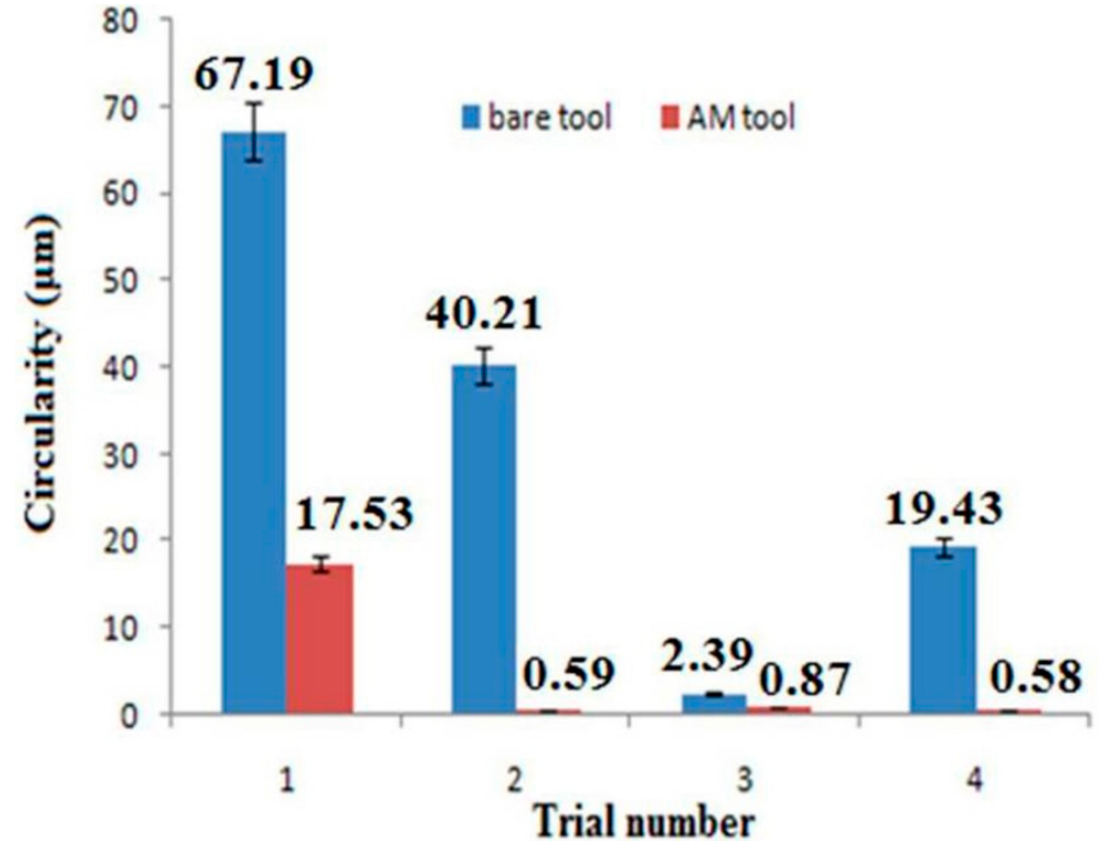
Figure 6. Comparison graph for bare tool and additive tool on circularity. Table 5 shows that a lower overcut was observed with the additive tool than with the bare tool. The lower overcut of specimens was observed with additive tool due to the layer by layer additive manufacturing of the tool electrode, as shown in Figure 7. It could be due to the high localization effect and minimization of stray current provided by additive manufacturing tool in the ECMM process. Table 5. Comparison table between Bare Tool and Additive Tool for Overcut. Trials